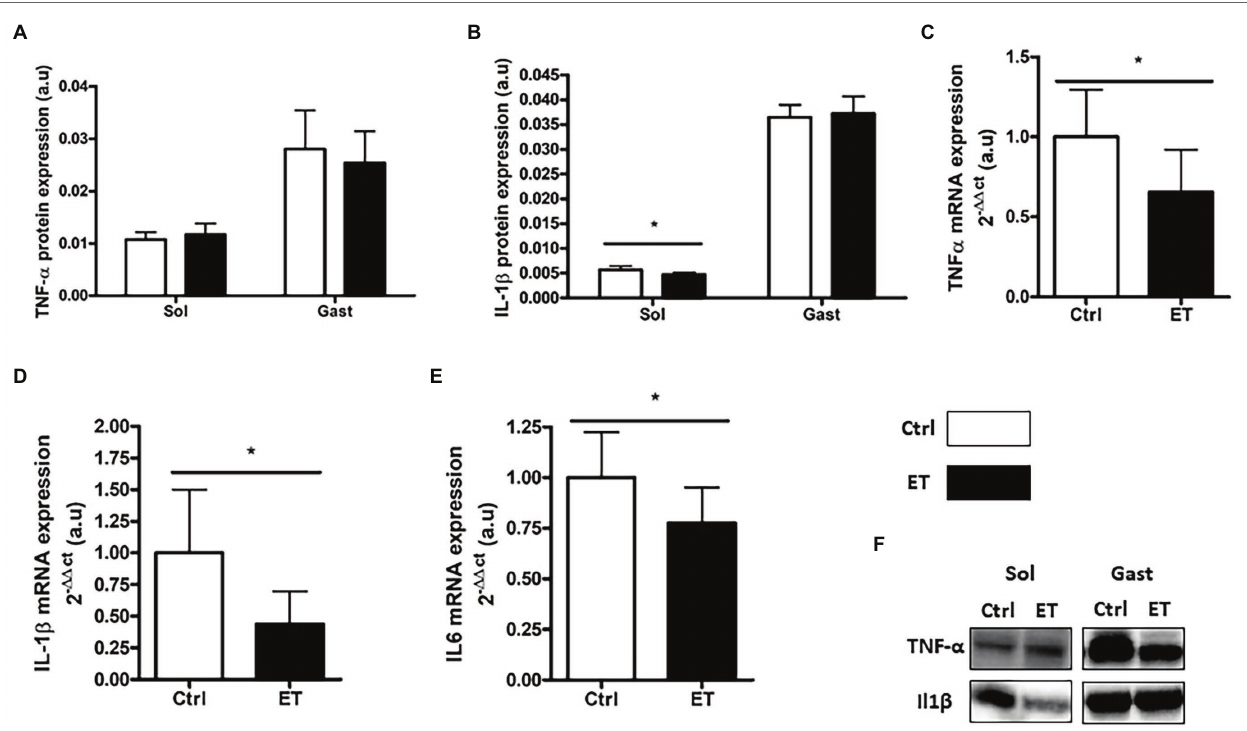
FIGURE 8 | Ergothioneine effect on muscle inflammatory markers 2 h after exercise. Inflammatory marker (protein and gene) expression in soleus and gastrocnemius samples. (A) TNF-a protein expression. (B) IL-1b protein expression. (C) Tnfa mRNA level. (D) IL-1b mRNA level. (E) IL6 mRNA level. (F) Representative Western Blots; * p < 0.05 vs. Ctrl.